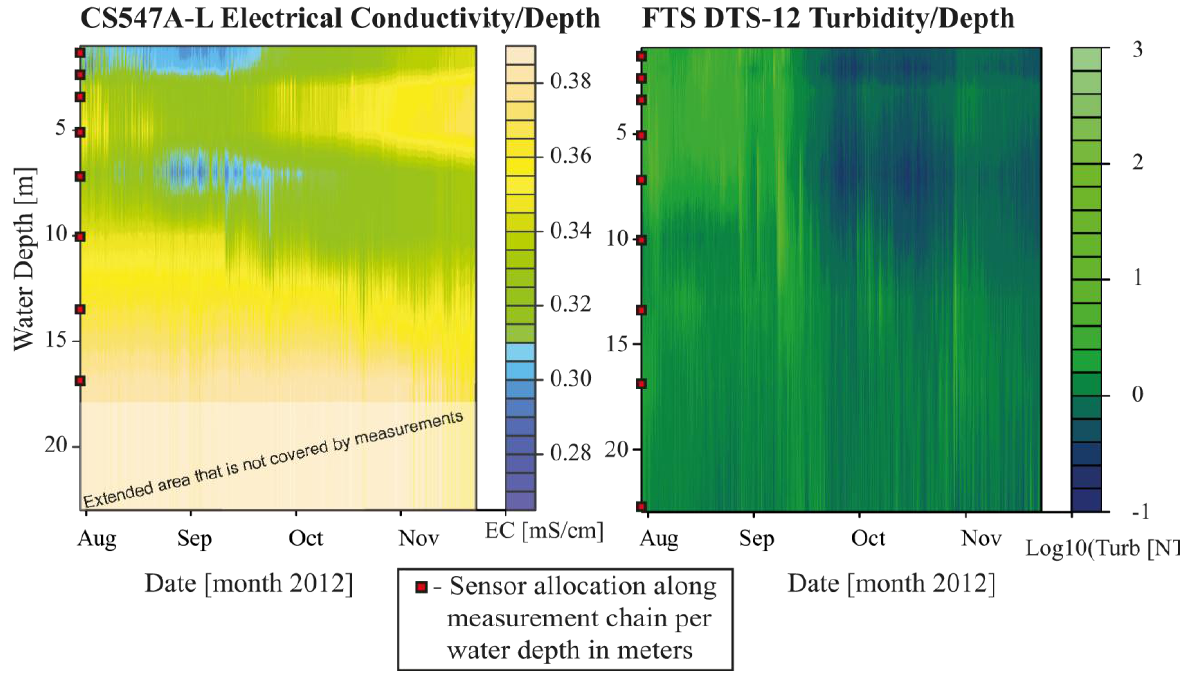
Figure 6. Electrical conductivity (CS547A-L, left plot ) and turbidity (FTS DTS-12, right plot ) displayed in contour plots at the buoy location. Sensor allocation by water depth is illustrated by the red squares. Turbidity is presented with a logarithmic